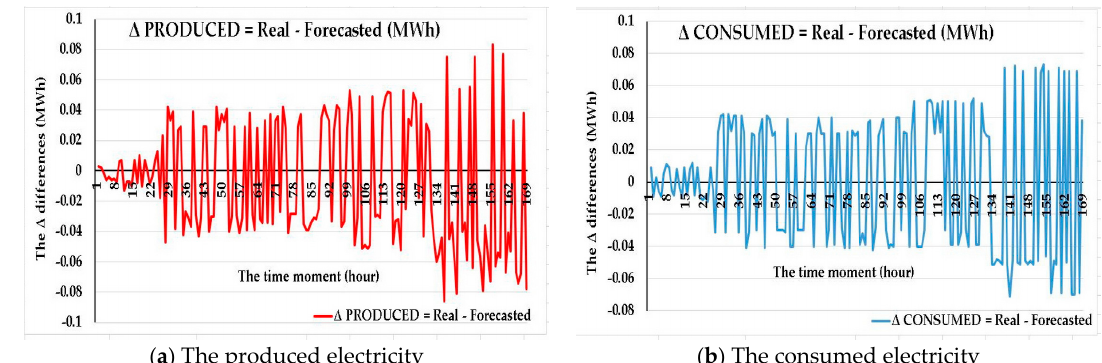
Figure 5. The Δ differences obtained when forecasting the produced and consumed electricity using the developed FITNET_BR ANN forecasting solution.